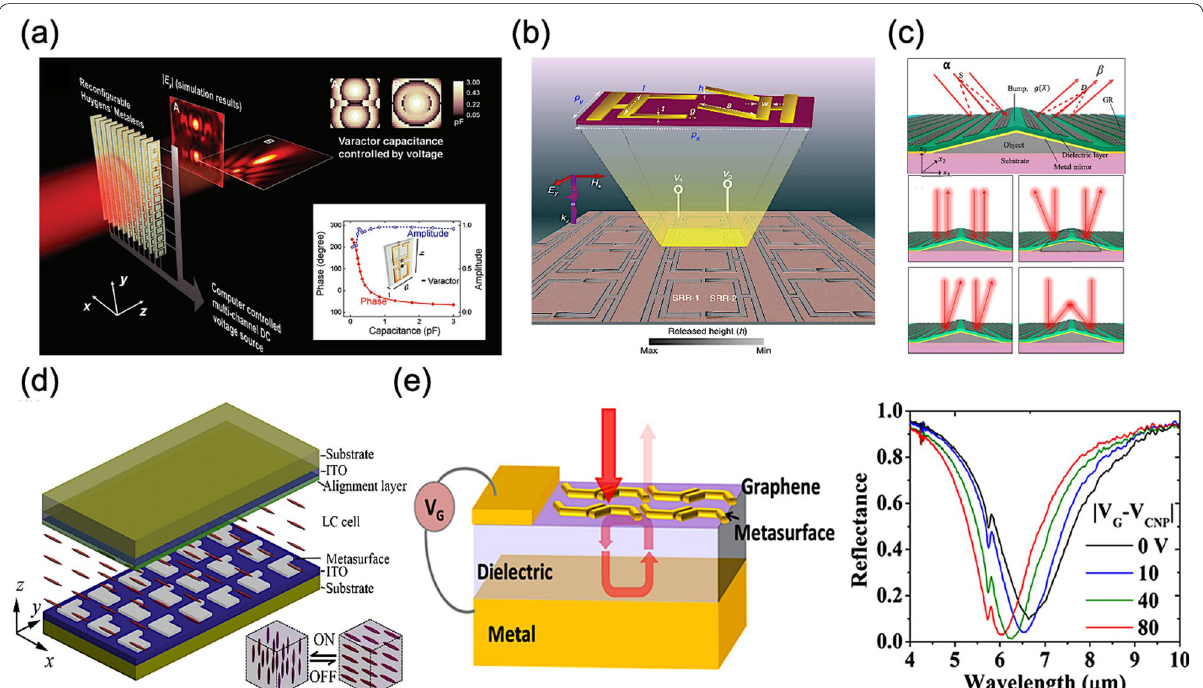
Fig. 6 Electrically reconfigurable and tunable metasurfaces a Active Huygens’ metalens controlled by multichannel DC voltage sources [85], b MEMS Fano metasurface with multiple‑input–output states for logic operations [86], c Metasurface with graphene ribbon array on a nonplanar surface [87], d Liquid–crystal‑loaded chiral metasurfaces for reconfigurable multiband spin‑selective light absorption [88], and e Ultrathin optical modulator based on a tunable metasurface absorber operating in mid‑infrared range